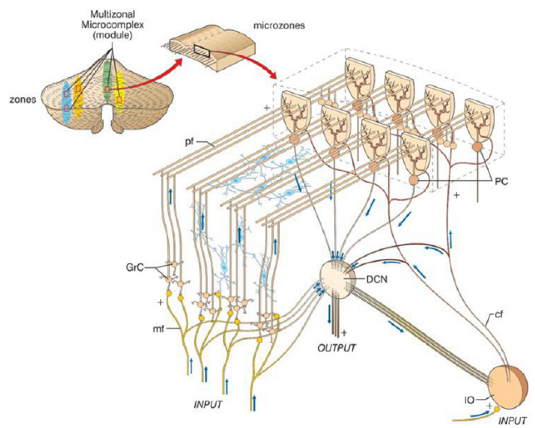
Figure 5. A schematic drawing of microzone, a functional unit in the cerebellar cortex. PC; Purkinje cells, GrC; granule cells, mf; mossy fiber, pf; parallel fiber cf; climbing fiber, DCN; deep cerebellar nucleus, IO; inferior olive nucleus. From: [23] Seeking a unified framework for cerebellar function and dysfunction: from circuit operations to cognition.